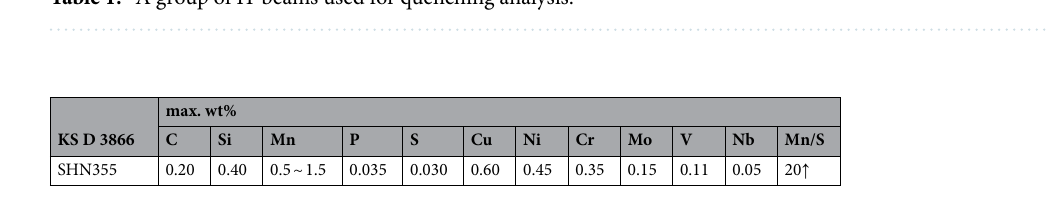
Table 2. Chemistry requirements of SHN355 in KS D 3866